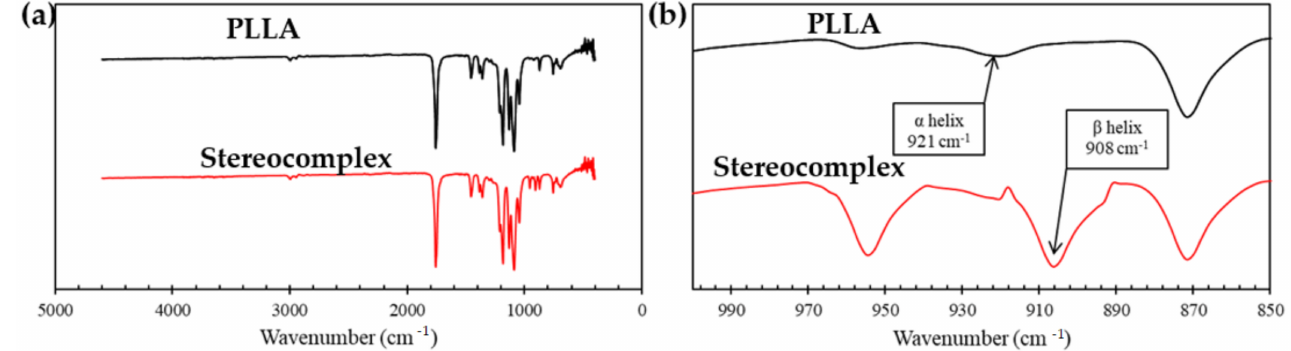
Figure 8. ( a ) FTIR spectra of the PLLA (black line) and stereocomplex PLA (red line). ( b ) FTIR spectra displaying characteristic absorption bands. The spectra displayed involves the stereocomplex PLA collection time at 20 min.